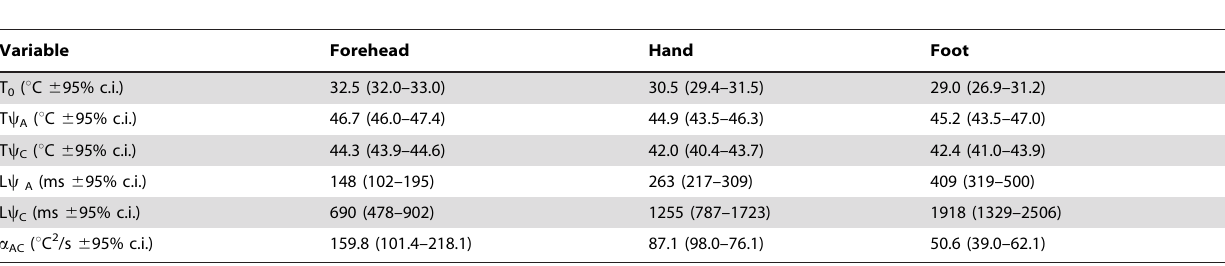
Table 3. Summary of psychophysical variables calculated following stimulation of three different parts of the body, namely the forehead, the hand and the foot in four healthy subjects.